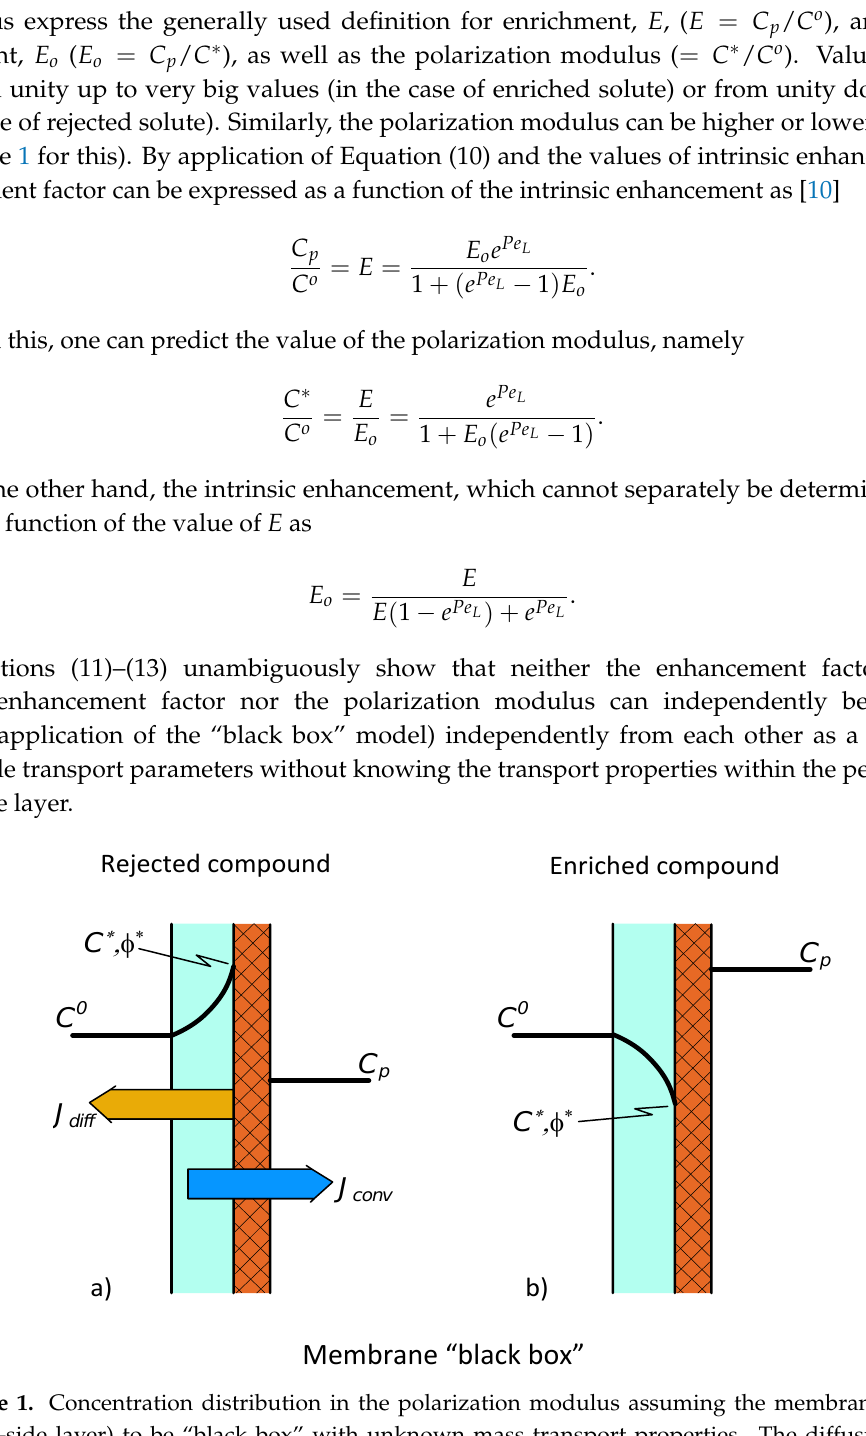
Figure 1. Concentration distribution in the polarization modulus assuming the membrane layer (right-side layer) to be “black box” with unknown mass transport properties. The diffusive and convective transports are in reverse ( a ) or concurrent directions ( b ).